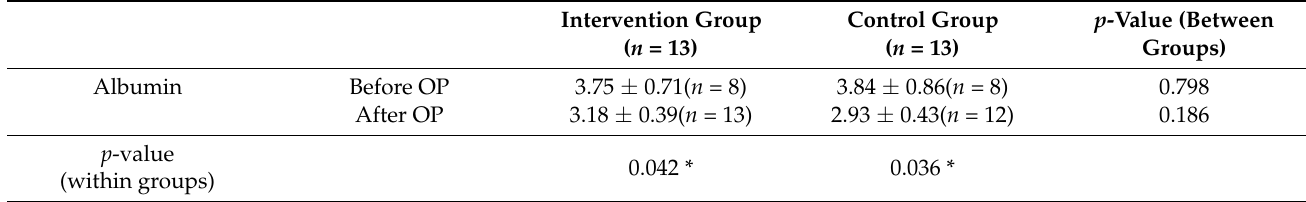
Table 4. The albumin level dropped significantly in both groups after